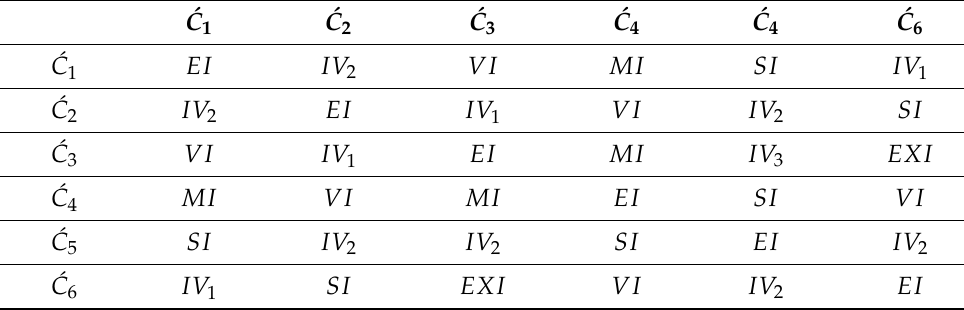
Table 8. Relative importance of